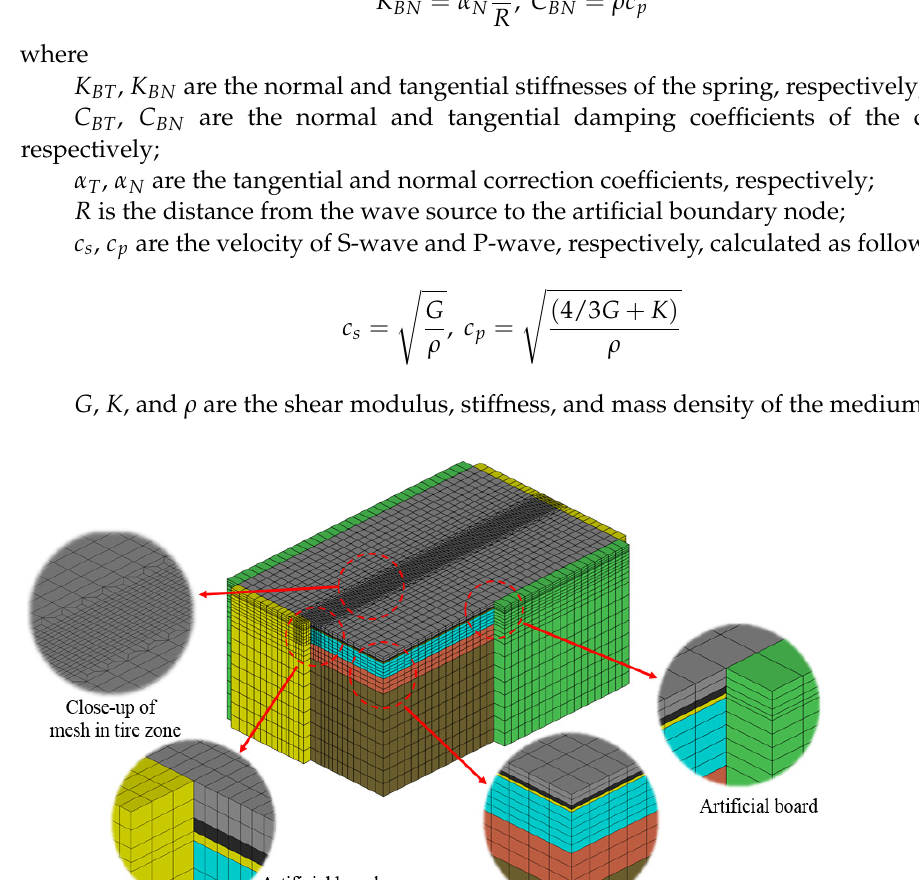
Figure 7. The FE model of semi-flexible ART pavement.